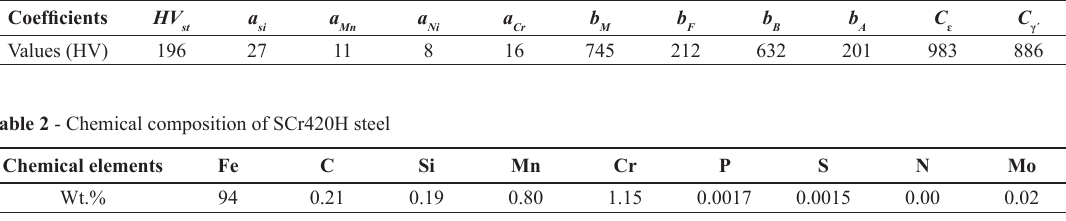
Table 1 - The values of coefficients for hardness calculation Coefficients